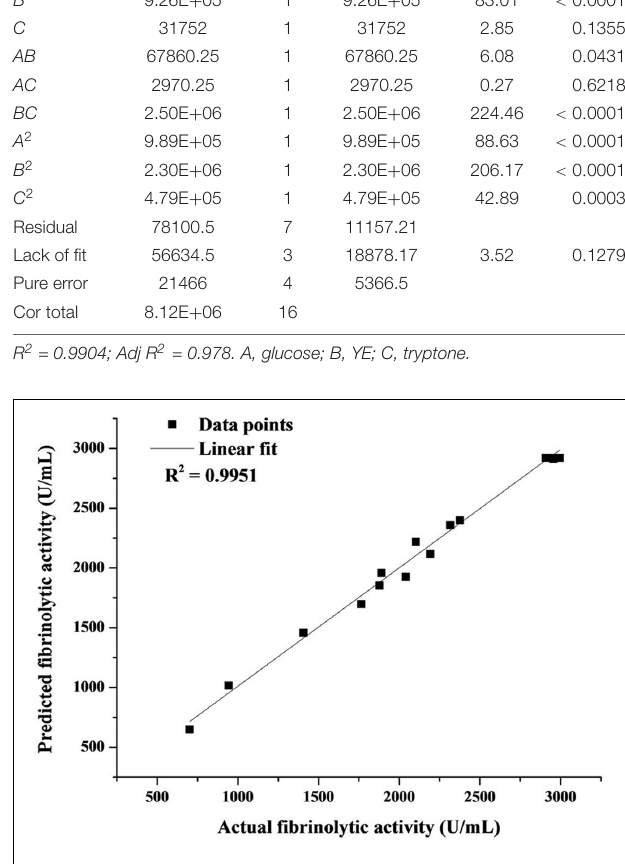
FIGURE 4 | Correlation between experimental and predicted fibrinolytic